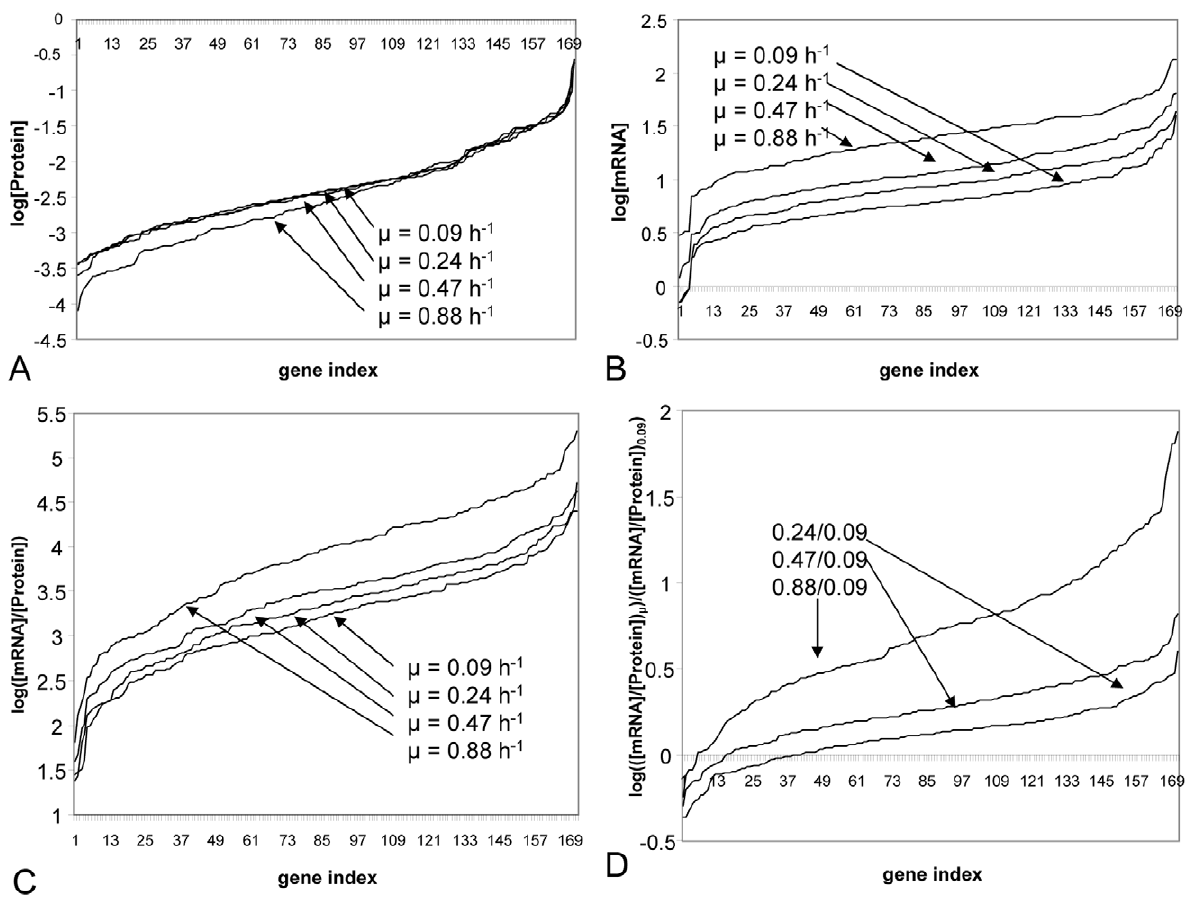
Figure 1. Distributions of protein and mRNA data for different growth rates in L.lactis . Protein concentrations (A), mRNA concentrations (B), mRNA/protein ratios (C) and their ratios between two different growth conditions (D) ranked in increasing order.